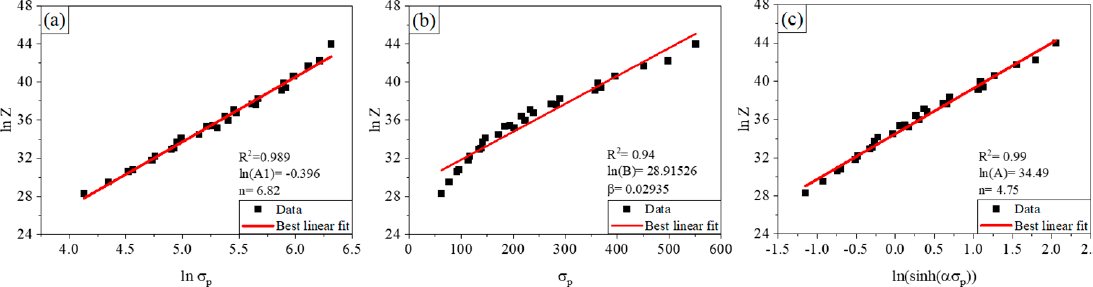
Figure 7. Relationships between the deformation parameters of the low-density steel ( a ) ln(Z) and ln( σ p ) ; ( b ) ln(Z) and σ p ; ( c ) ln(Z) and ln(sinh( ασ p )) .